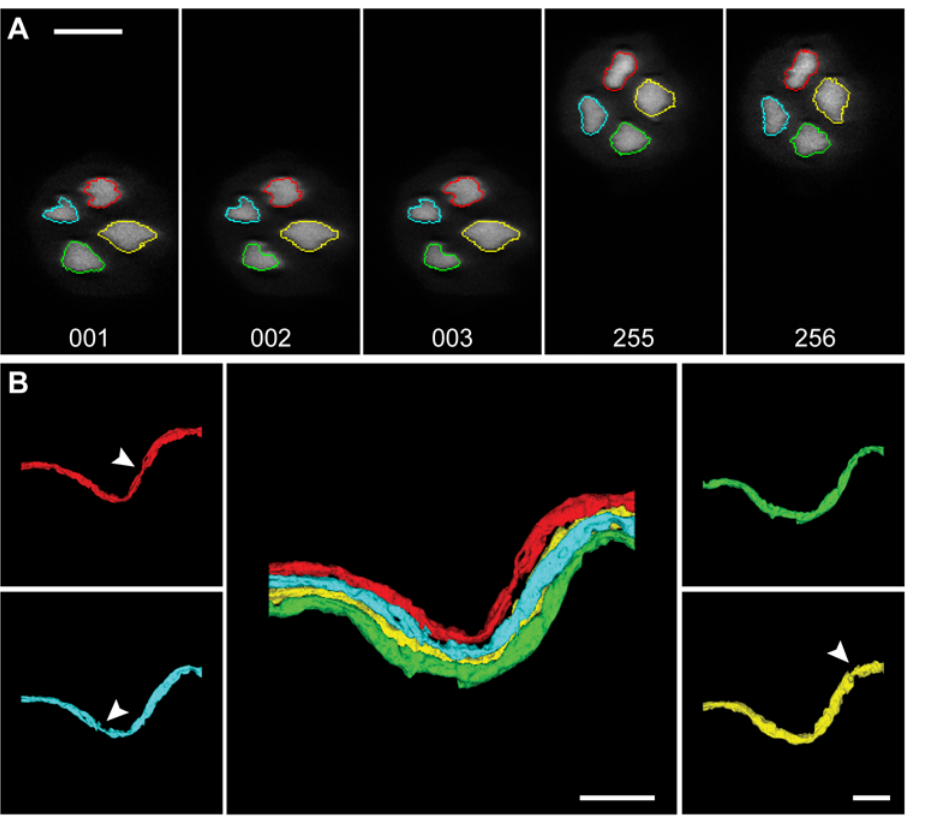
Figure 2. Reconstruction of an un-branching nerve fascicle. A . Axons in the nerve fascicle were traced out across multiple sections. Traces on the first 3 sections and the last 2 sections of the stack are shown. Scale bar: 10 m m. B . Traced axons were rendered in Reconstruct . Constrictions in the axons (arrows) represent nodes of Ranvier. Scale bars: 20 m m.